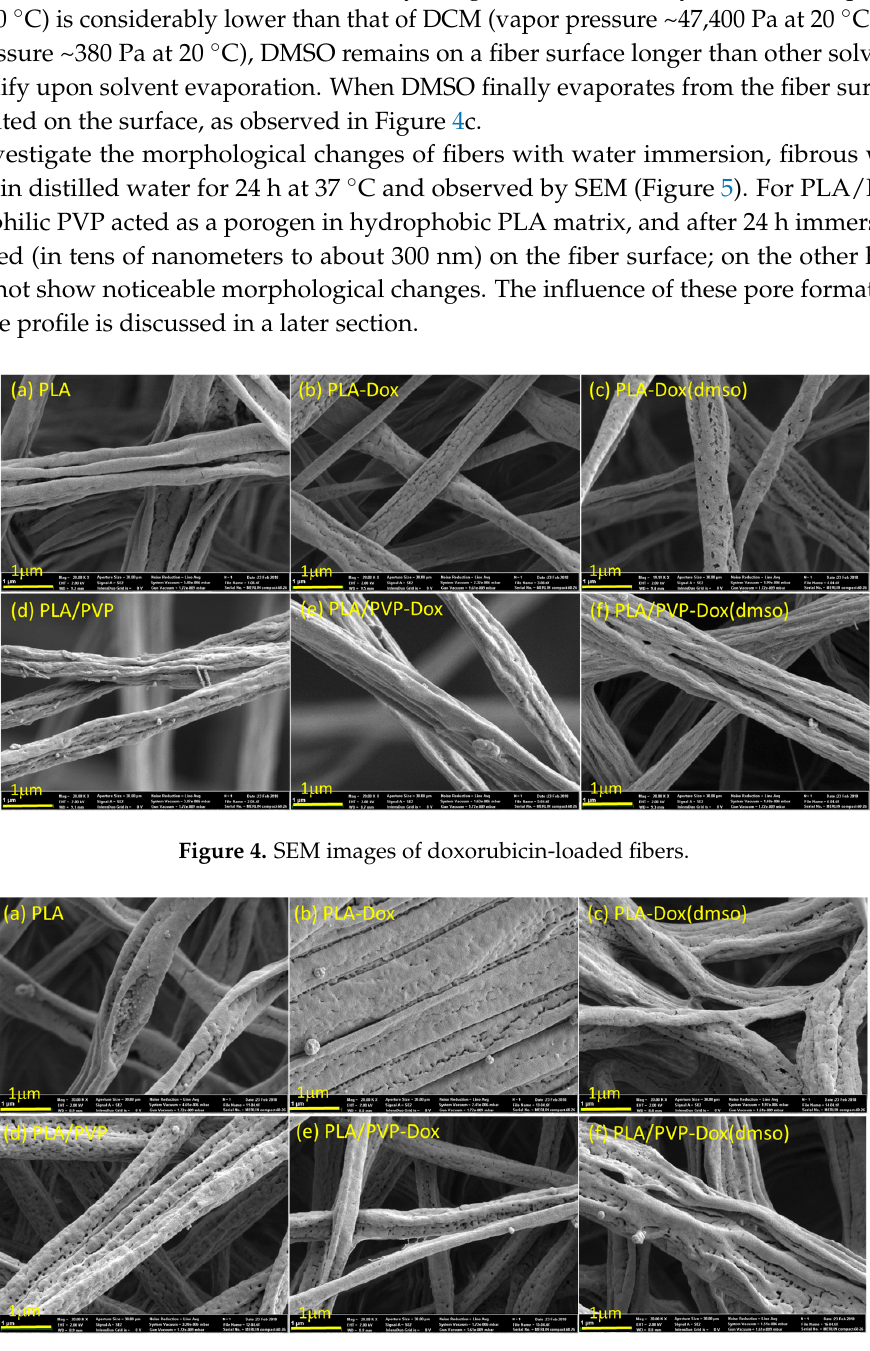
Figure 5. SEM images of doxorubicin-loaded fibers after immersion in water for 24 h.